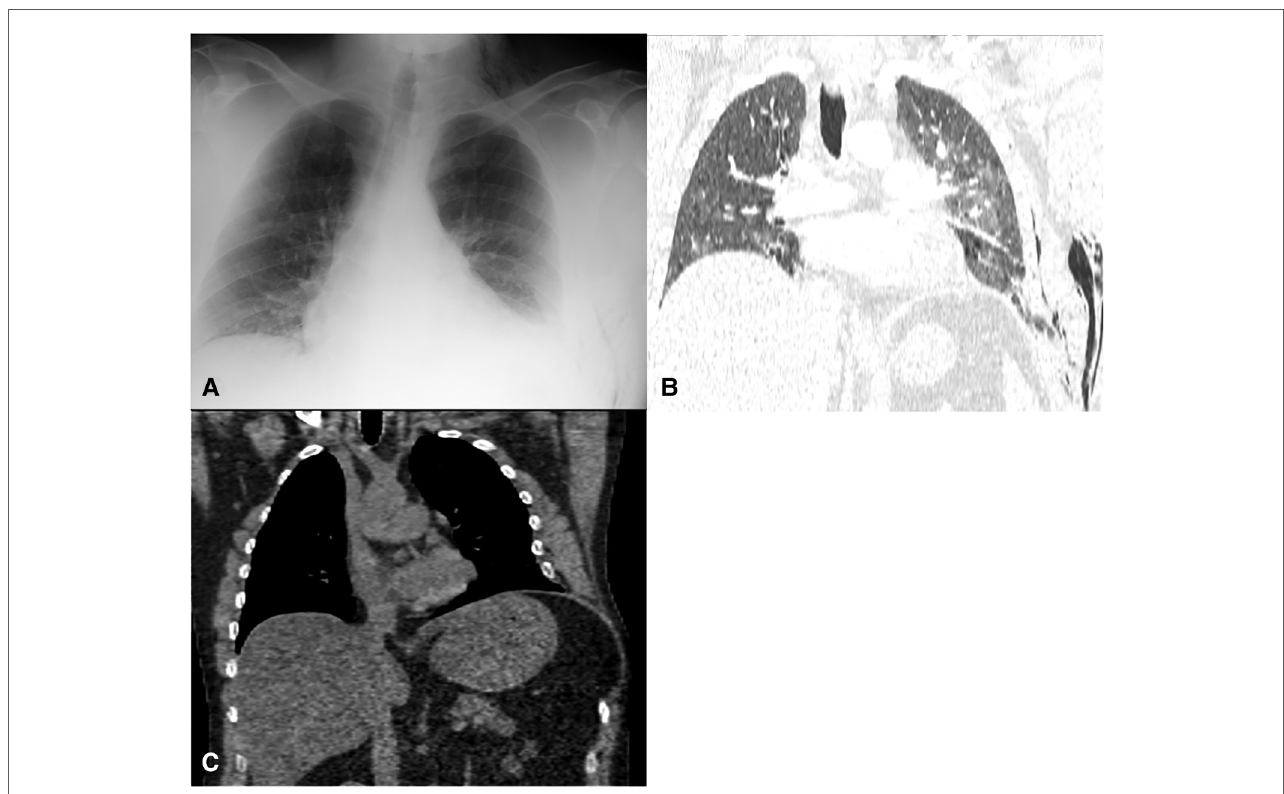
FIGURE 2 36-year-old man, BMI 40.3, with a left SLIH presenting with extensive bruising, abdominal pain, and shortness of breath. ( A ) chest x-ray at presentation showed an subcutaneous emphysema within the left axillary region and supraclavicular fossa. ( B ) CTPA revealed a moderate left pneumothorax without tension, a left abdominal wall and neck subcutaneous emphysema, left effusion, and a displaced fracture of the left lateral 8th rib. Lung herniation was not reported; however, on a retrospective review, a small left-sided lung hernia could be identi fi ed. ( C ) A CT scan revealed a herniation of a small lingula portion, abdominal fat, and lateral aspect of the diaphragm, and old rib fractures of the 6th lateral rib, 7th non-united lateral rib with a 15-mm gap, and 8th posterior rib with callus formation with displacement of the anterior portion of the eighth rib more anteriorly with a wide separation of the distracted